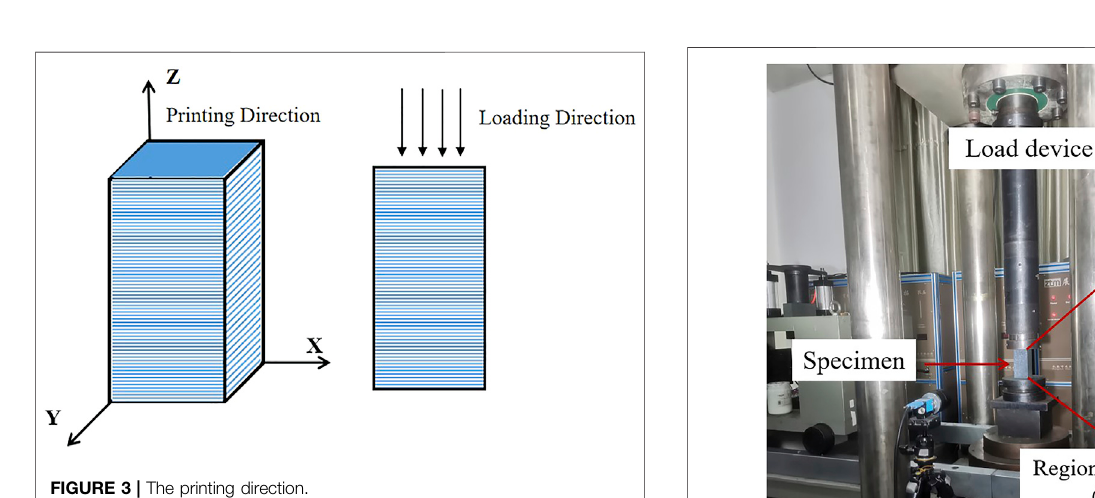
FIGURE 2 | Specimen printing process.